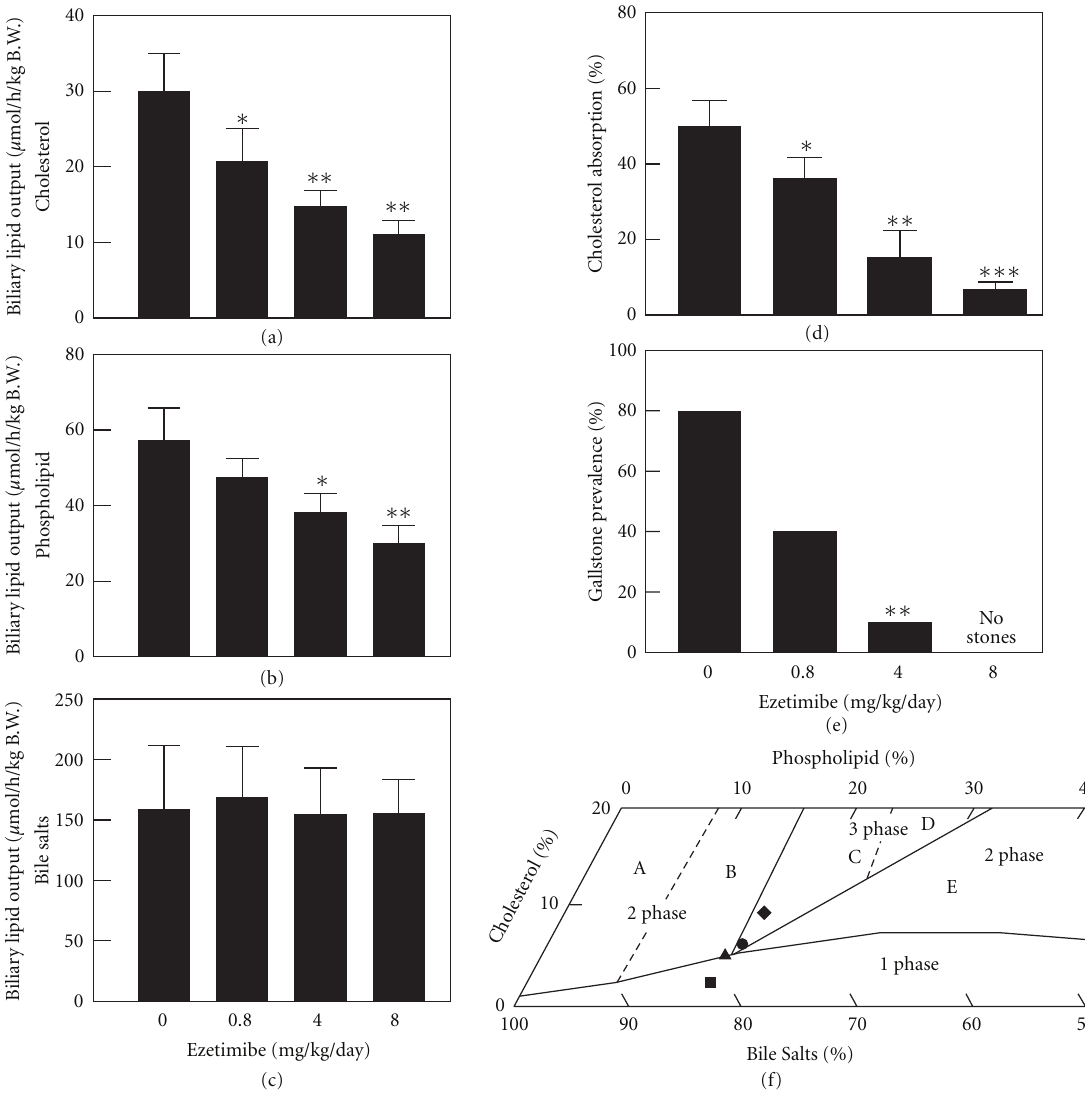
Figure 3: E ff ect of ezetimibe on the prevention of cholesterol gallstones. Ezetimibe significantly reduced, in a dose-dependent fashion, hepatic output of (a) biliary cholesterol and (b) phospholipid, but not (c) bile salts. ∗ P < 0 . 05, ∗∗ P < 0 . 01, and ∗∗∗ P < 0 . 001, compared with mice fed the lithogenic diet and receiving no ezetimibe. (d) There is a clear dose-dependent reduction in intestinal cholesterol absorption e ffi ciency from 50 ± 6% to 4 ± 2% in chow-fed with mice, as measured by the fecal dual-isotope ratio method. (e) When doses of ezetimibe are increased from 0 to 4 mg/kg/day, gallstone prevalence rates are reduced from 80% to 10% in mice fed with the lithogenic diet for 8 weeks. No gallstones are found in mice treated with ezetimibe at 8mg/kg/day. (f) The relative lipid composition of pooled gallbladder bile from mice fed with the lithogenic diet and receiving no ezetimibe are located in the central three-phase zone, where bile is composed of solid cholesterol monohydrate crystals, liquid crystals, and saturated micelles at equilibrium. In contrast, administration of the highest dose (8mg/kg/day) of ezetimibe resulted in the relative biliary lipid composition of pooled gallbladder bile plotted in the one-phase micellar zone, even upon the lithogenic diet feeding for 8 weeks. By phase analysis, these bile samples are composed of unsaturated micelles at equilibrium. A symbol (cid:2) represents relative lipid composition of pooled gallbladder bile at 8 weeks on the lithogenic diet supplemented with ezetimibe at 0; • 0.8; (cid:3) 4; (cid:4) 8mg/kg/day. Reproduced with modifications and with permission from